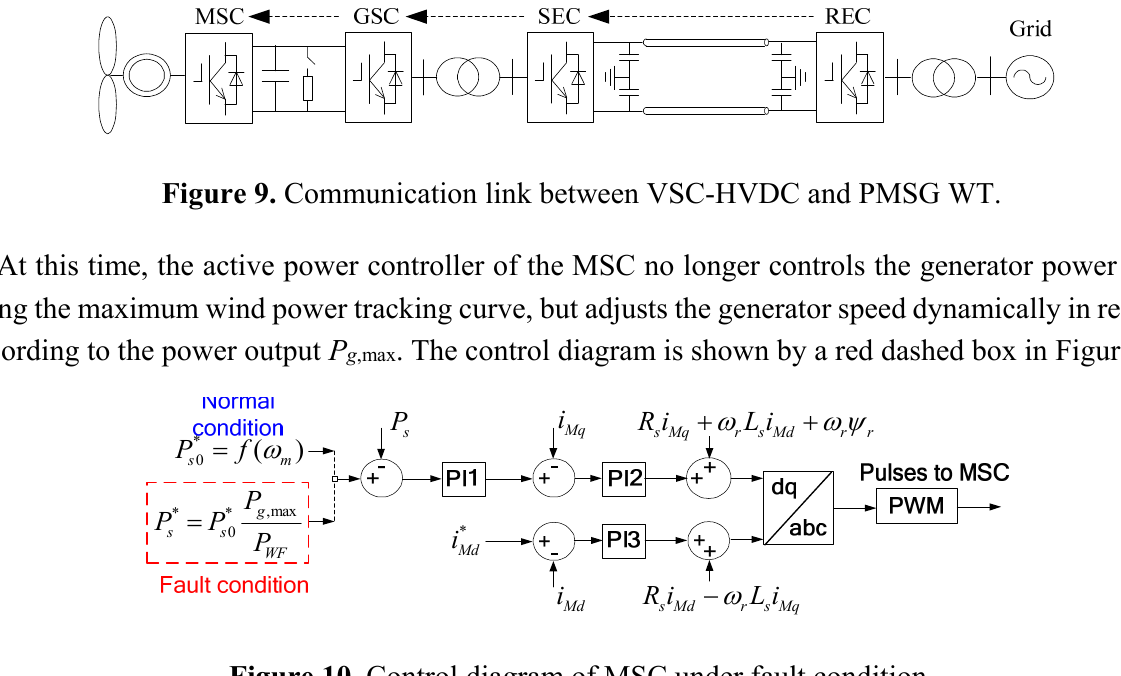
Figure 10. Control diagram of MSC under fault condition.